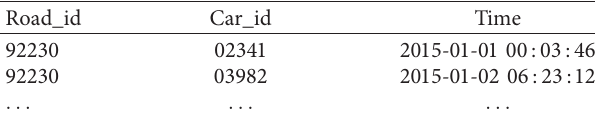
Figure 6: Part of the road network map of Luohu District, Shenzhen. Table 1: Shenzhen taxi GPS record information example.